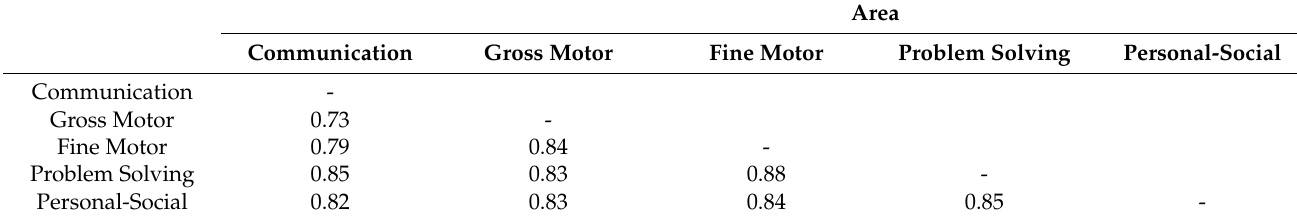
Table 6. Correlations between ASQ-3 developmental area scores.